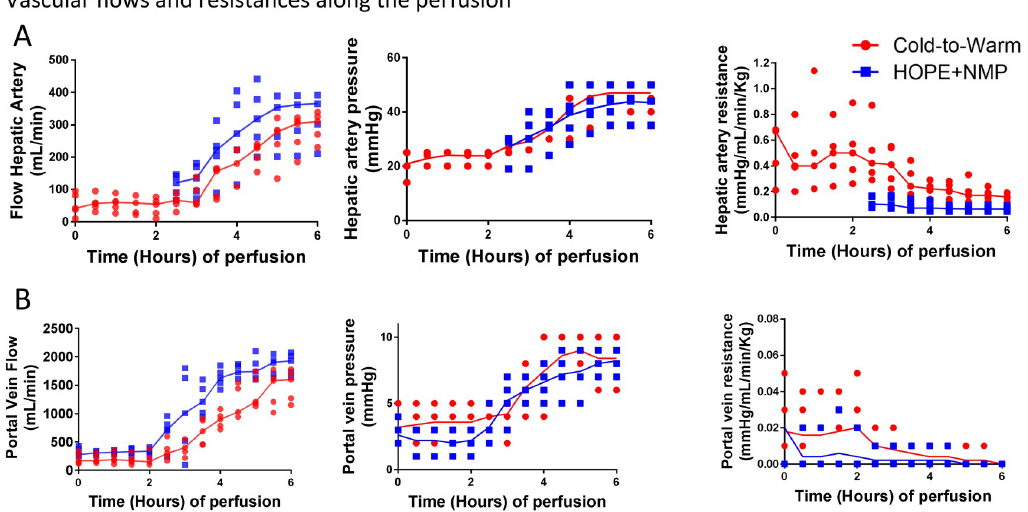
Fig 4. Vascular parameters throughout the perfusion protocols. Panel A shows hepatic artery vascular parameters. The flow was higher for the HOPE+NMP group, despite slightly higher pressures used for the cold-to-warm group in an attempt to overcome the higher vascular resistance. A similar trend was seen for the portal vein vascular parameters (Panel B). The cold-to- warm group had higher vascular resistance mainly during the hypothermic phase, which improved during the rewarming. The higher vascular resistance required increases in the perfusion pressures, although the vascular flows were still lower during the initial period of the NMP phase. In the graphs, dots represent individual organs at the time points and the line is the median of the values for each